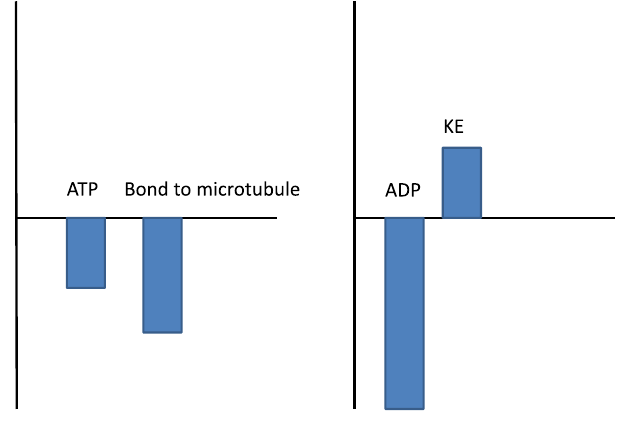
FIG. 4. A reconstruction of the bar graphs drawn by Peter ’ s